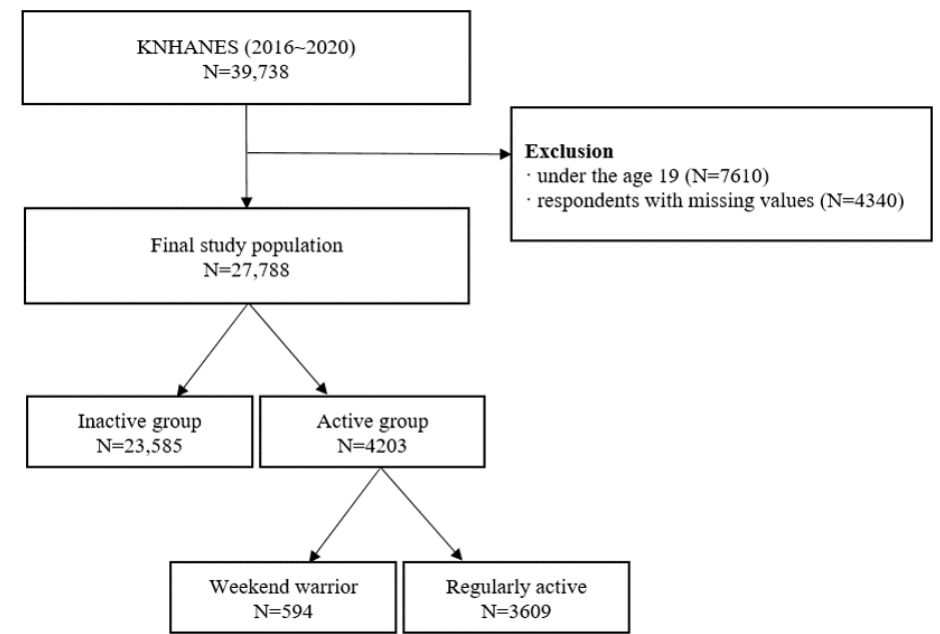
Figure 1. Flowchart of the study participants displaying the inclusion and exclusion.